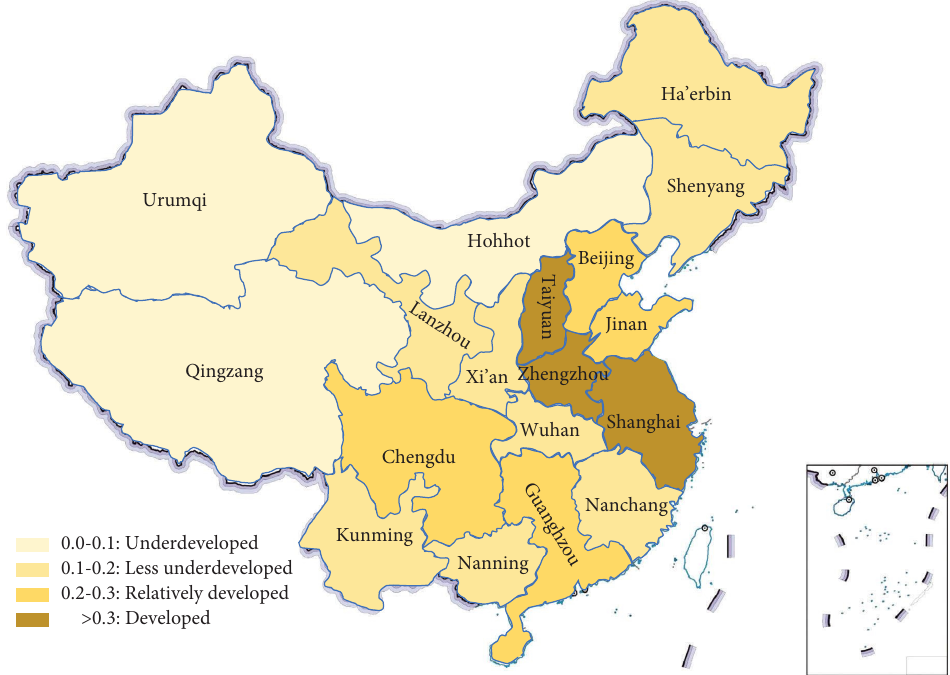
Figure 3: Te assessment results of 18 railway